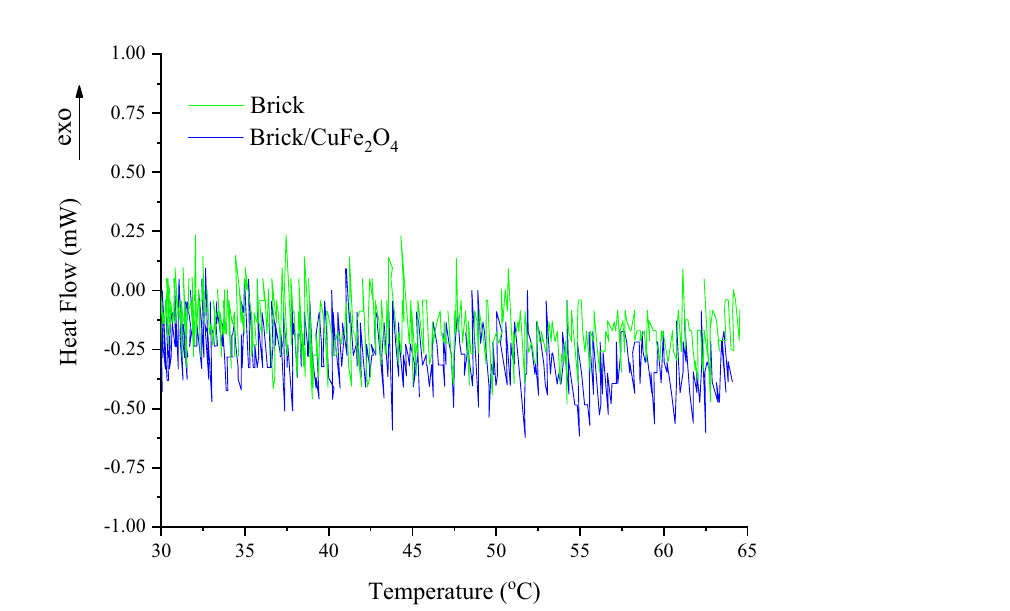
Figure 5. DSC thermograms of the brick and brick/CuFe 2 O 4